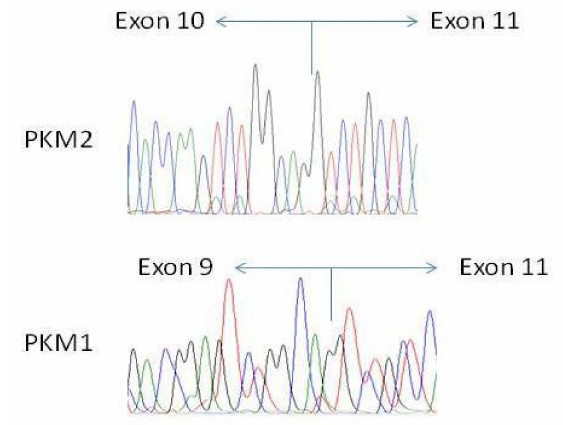
Figure 6. Sequencing of amplicons confirms the presence of both isoforms (exon 9 including–PKM1 and exon 10 including–PKM2), in all cell lines (presented is